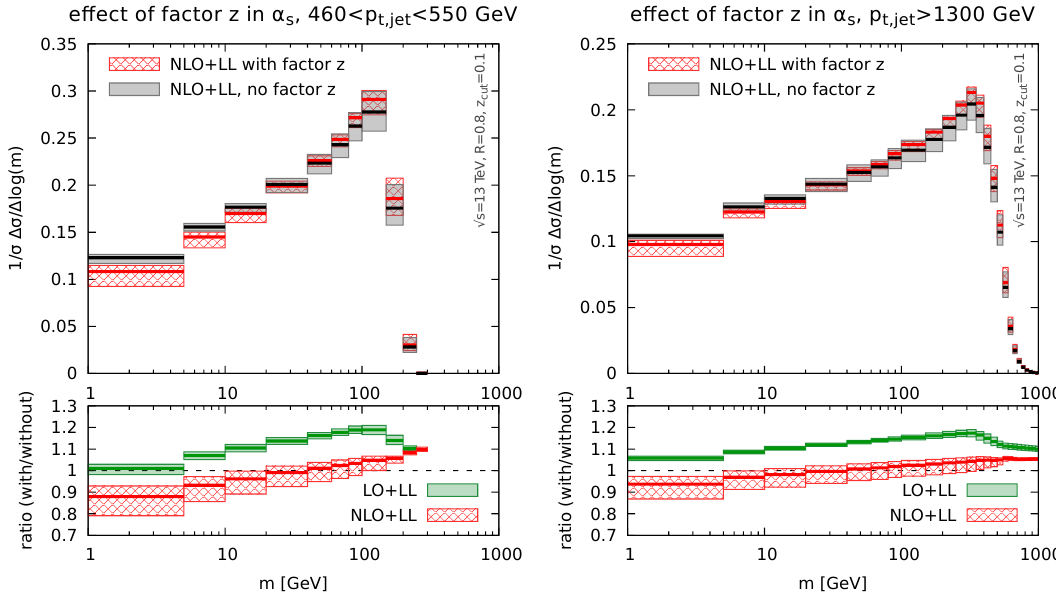
Figure 14 . Comparison of the jet mass distribution with and without the resummation of loga- rithmic corrections in z cut originating from the running of the strong coupling. We note that these e(cid:11)ects are sizeable, although still within the theoretical